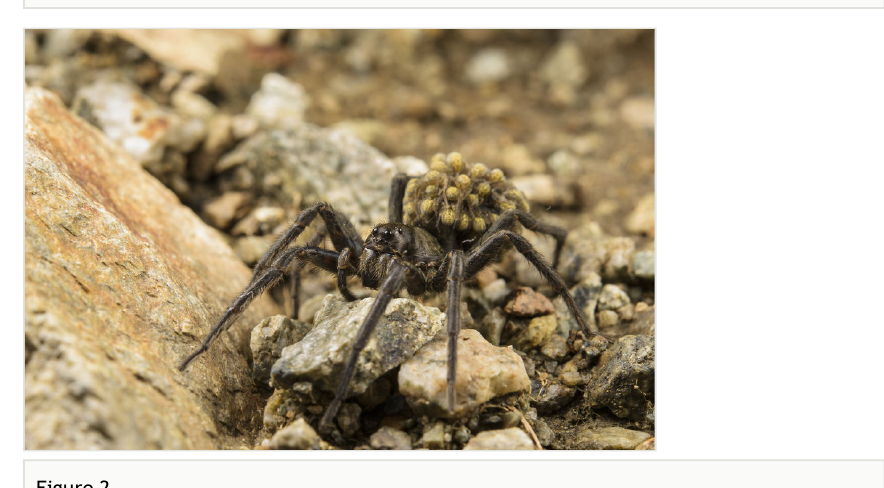
Figure 1. Habitus of Vesubia jugorum — female. [Photo credit: Emanuele Biggi, 2003]